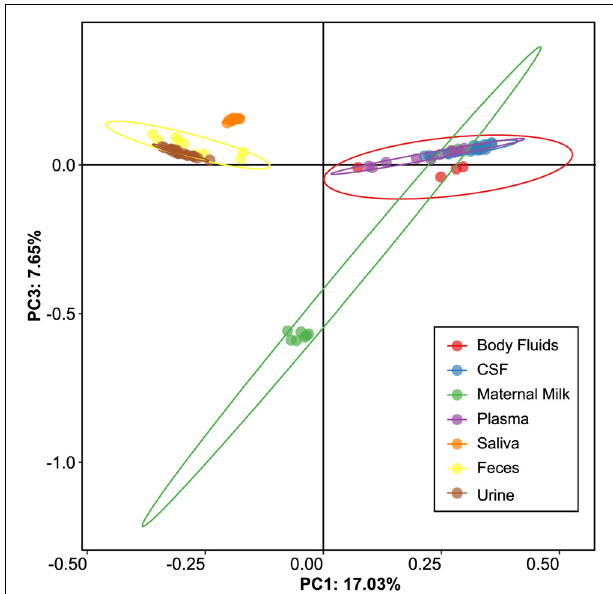
FIGURE 2 | Representation of beta-diversity based on Bray Curtis distances, shown in Principal coordinates analysis of the viral communities. Ellipses are drawn at 95% confidence intervals for sample type.